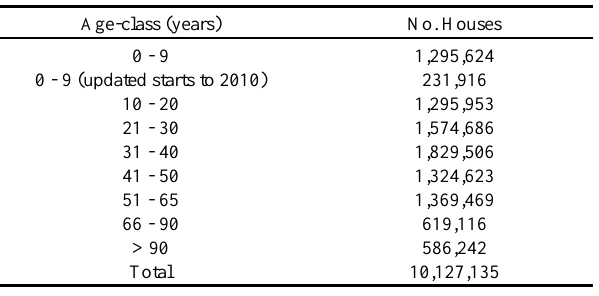
Table 2 . Number of houses in Canada by age class (their classes) from Natural Resources Canada (2006) and the 2006 Census (Statistics Canada 97-554-XCB2006022) with updates for recent housing starts from quarterly updates of the Canada Housing and Mortgage